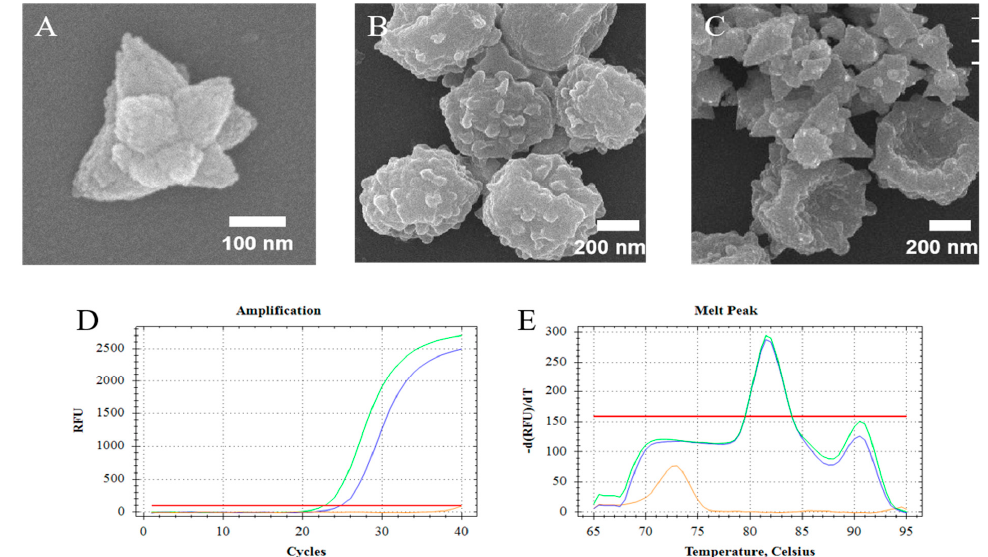
Figure 2. Study on the application of ZnO for the lysis of fungal spore cells. ( A ) Scanning electron microscope (SEM) images of synthesized nanoparticles ZnO-S-300; ( B ) SEM images of untreated A. fumigatus spore cells; ( C ) SEM image of the lysis process of ZnO-S-300 on A. fumigatus spore cells. ( D , E ) Fluorescence signals and melt data from real-time PCR analyses of amplified DNAs extracted by the ZnO-based fungal DNA isolation assay (Blue line) and kit assay (Green line). For the ZnO-based fungal DNA isolation assay, the cells were incubated for 60 min at room temperature. The extracted DNA of A. fumigatus spore cells (10 8 cells) was eluted in 100- µ L elution bu ff er. The orange line was the negative control which is pure elution bu ff er. Fluorescence intensity is measured in relative fluorescence units (RFU) by real-time polymerase chain reaction